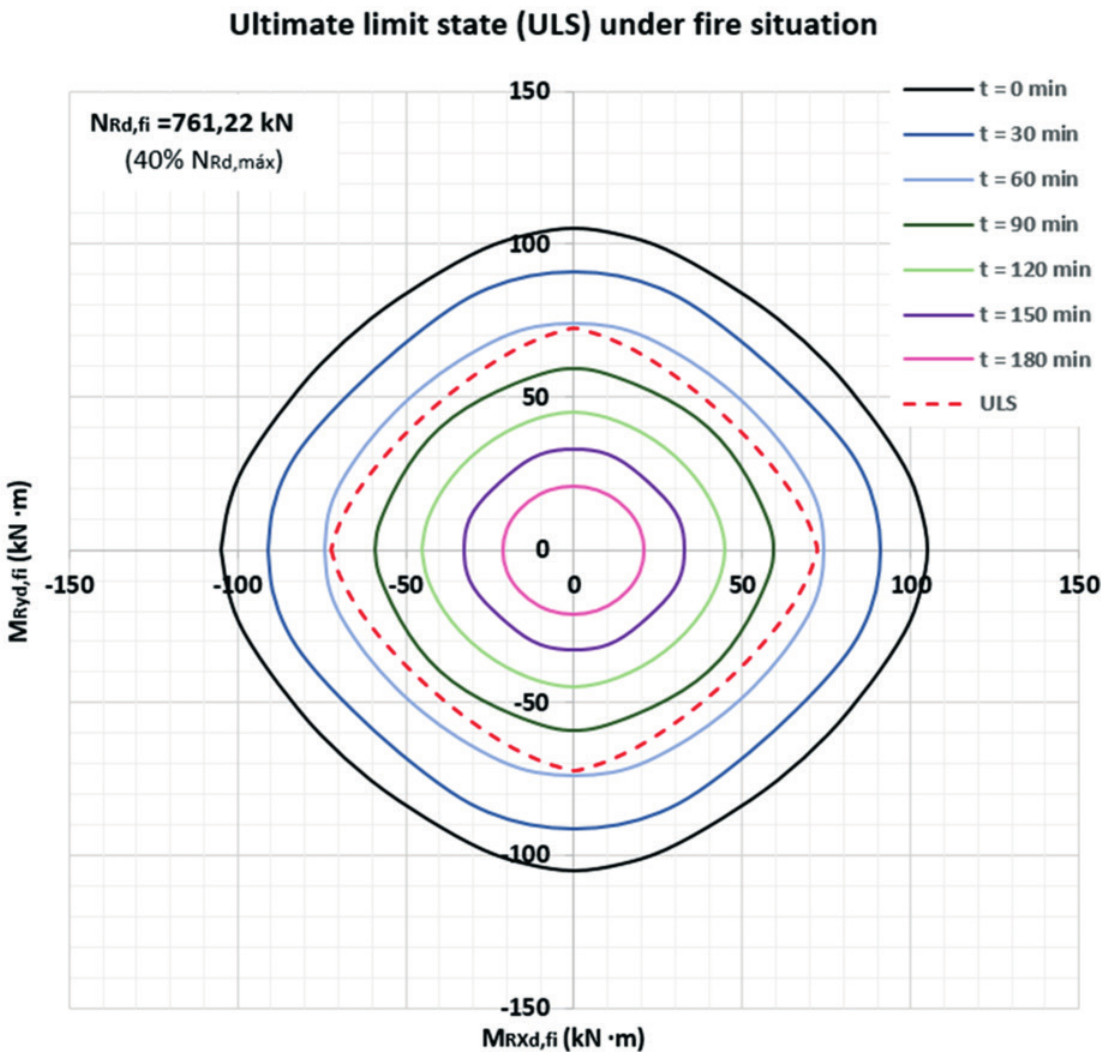
ULS interaction diagram insertion, at ambient temperature, over the ULS interaction diagrams, in fire